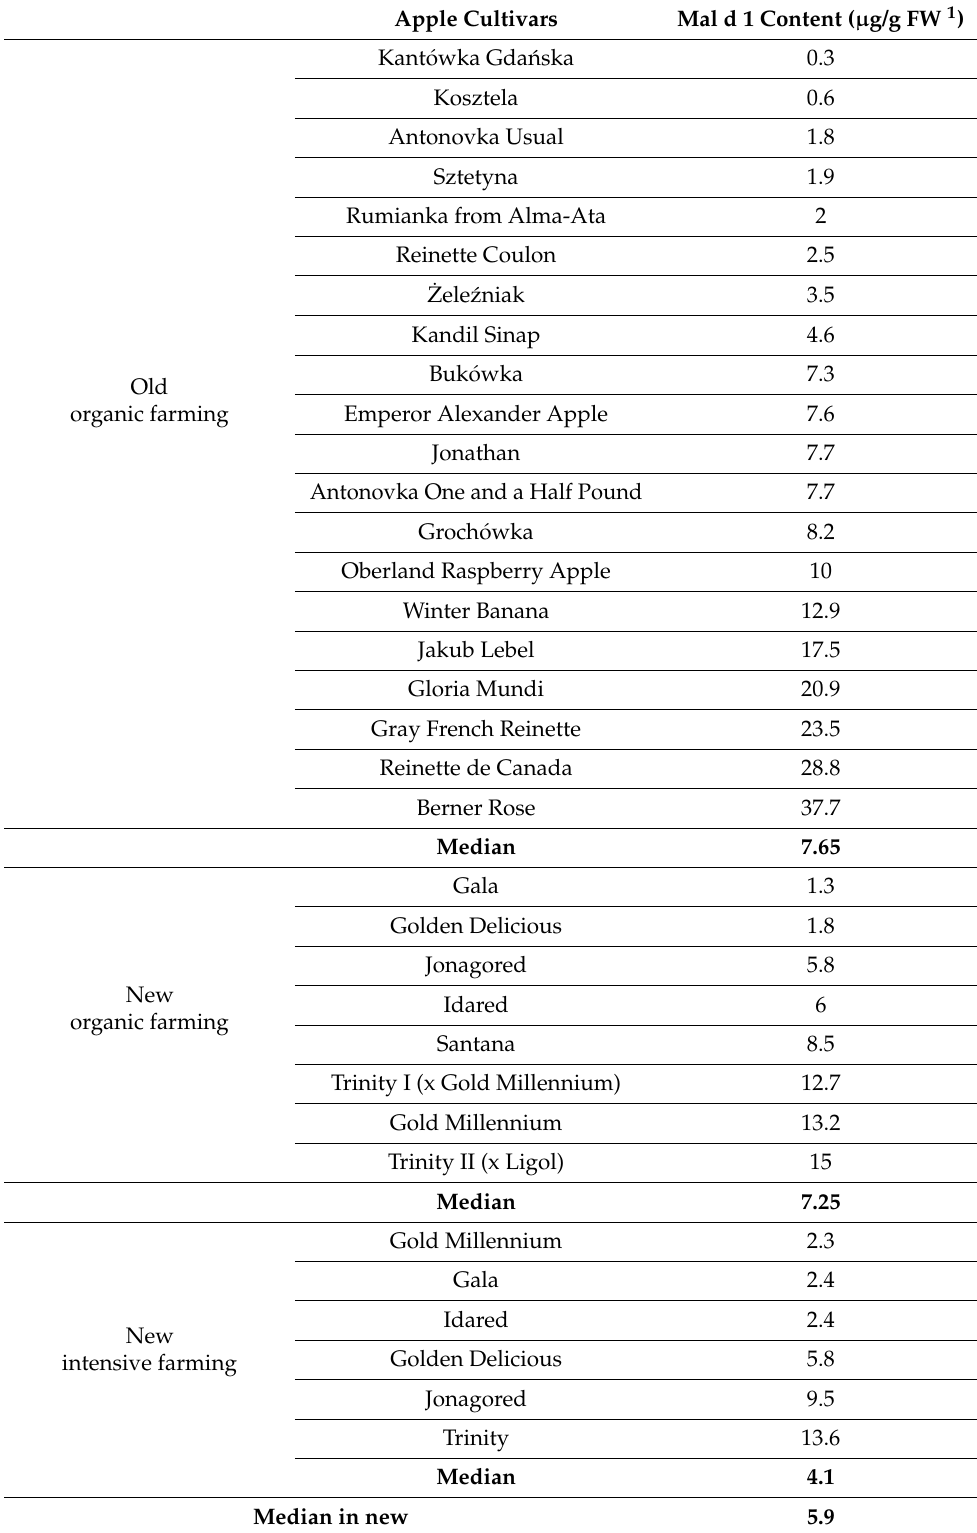
Table 2. Mal d 1 protein content in apple